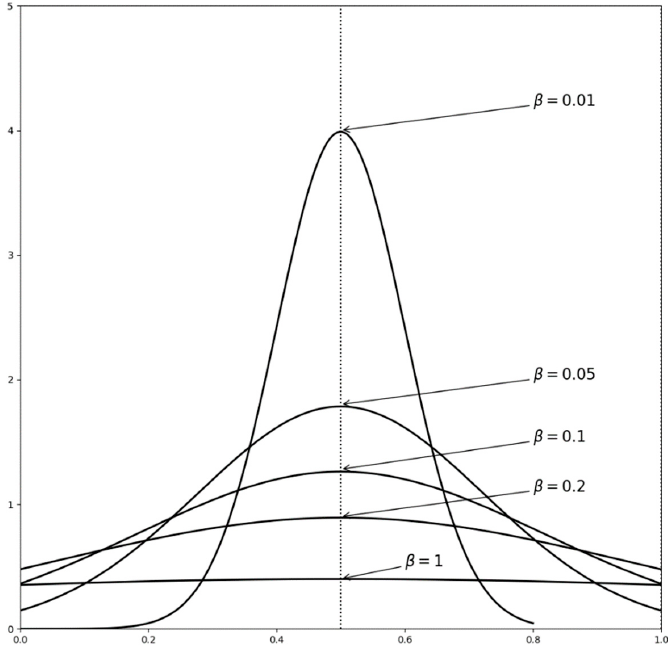
Figure 2. The diagram of the relationship between β and µ 0